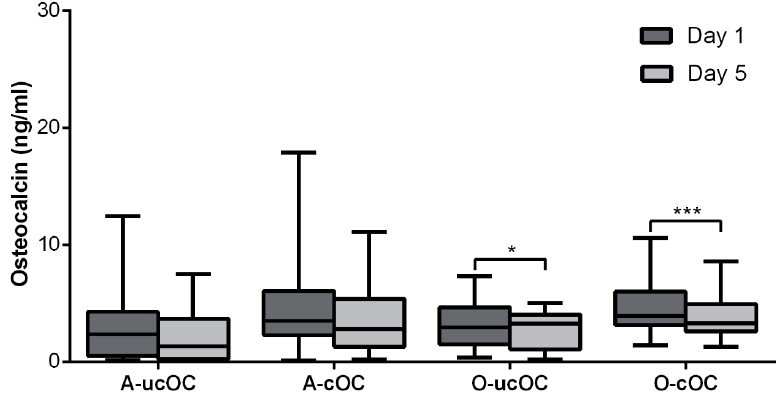
Figure 3. Boxplot changes in OC concentrations over time (A = abdominal surgery, O = orthopaedic surgery, ucOC = uncarboxylated osteocalcin, and cOC = carboxylated osteocalcin). Significance levels: * p < 0.05 and *** p ≤ 0.001.